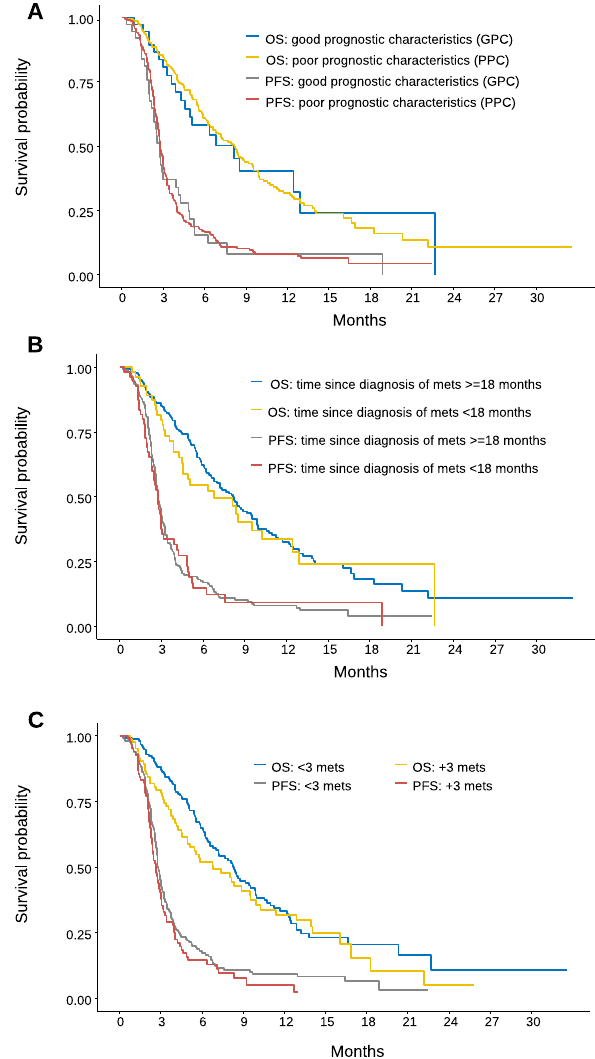
Figure 2. Kapplan Meier OS and PFS curves according to groups of the RECOURSE clinical trial. ( A ) Kapplan Meier OS and PFS curves according to group of good vs poor prognostic characteristics; ( B ) Kapplan Meier OS and PFS curves of indolent (time since diagnosis of metastasis ≥ 18 months) vs aggressive disease (time since diagnosis of metastasis < 18 months); ( C ) Kapplan Meier OS and PFS curves of the groups of low (< 3 metastatic sites) vs high (≥ 3) tumor burden. Abbreviations: OS, overall survival; PFS, progression-free survival; mets,